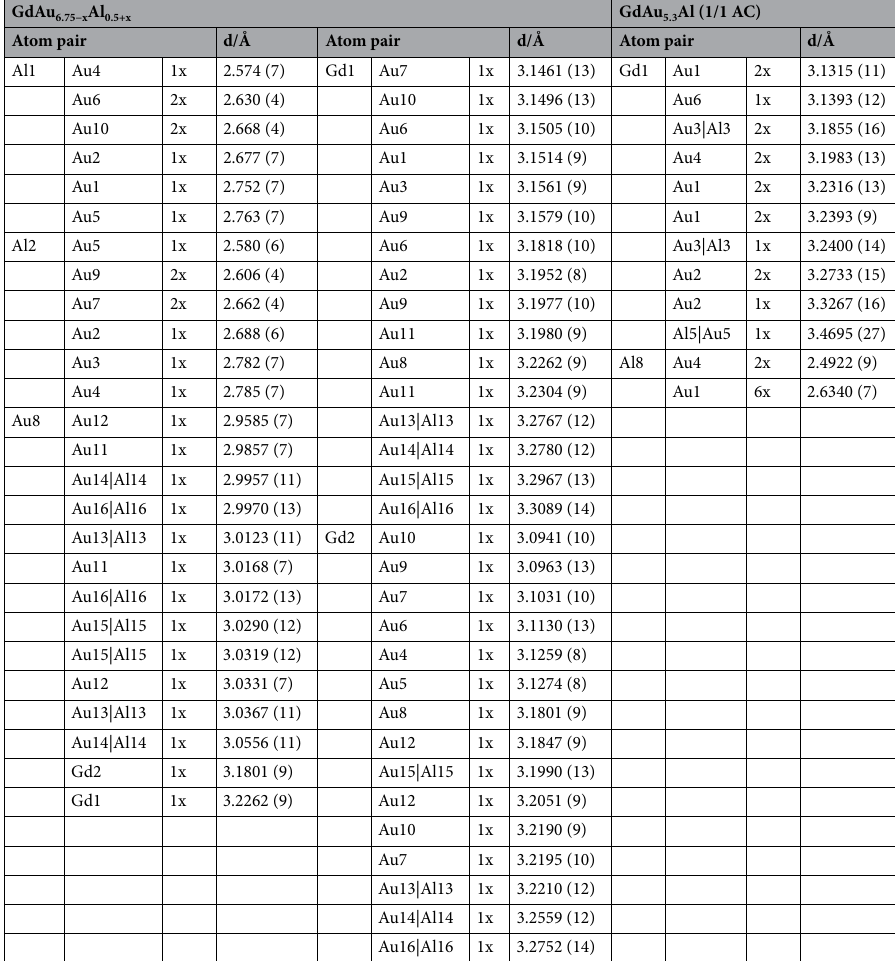
Table 3. Interatomic distances for GdAu 6.75−x Al 0.5+x and GdAu 5.3 Al (1/1 AC) polyhedra obtained from SC-XRD